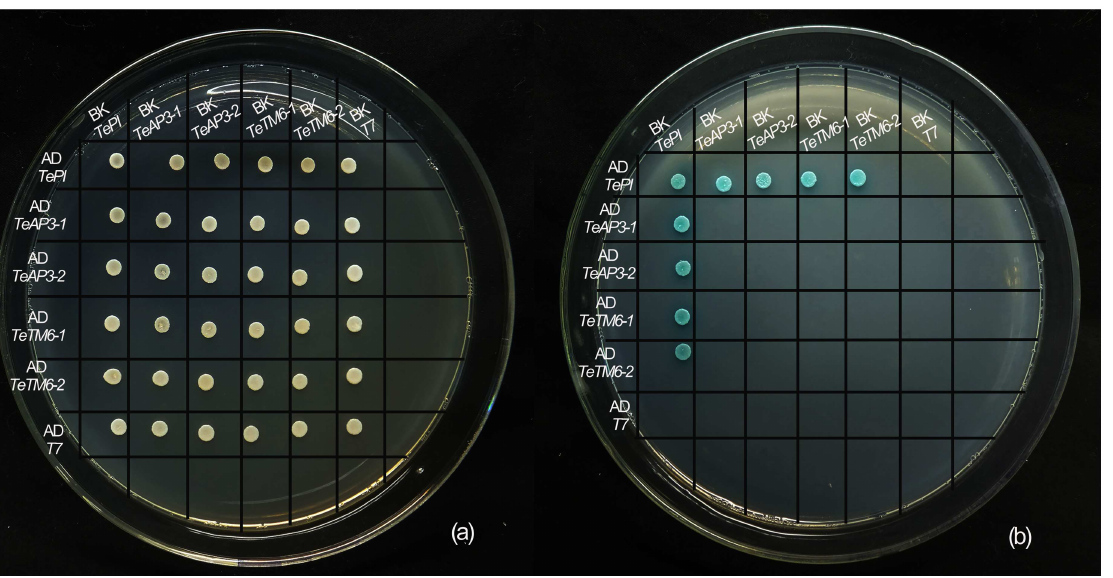
PLOS ONE | DOI:10.1371/journal.pone.0169777 January12,